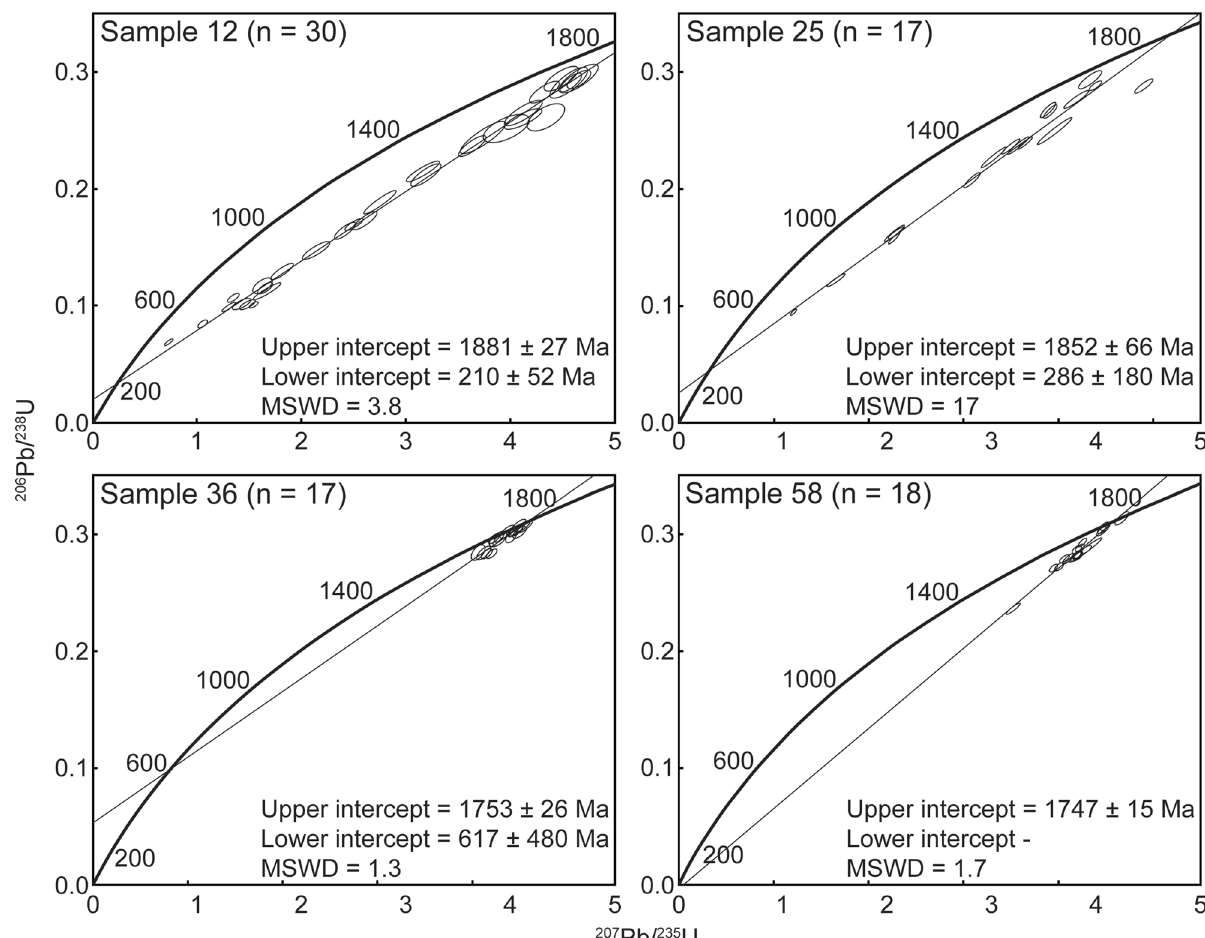
Figure 2. Representative concordia plots for samples outside the central plateau (samples 12 = Järna granite and 25 = Siljan granite) and inside the central plateau (samples 36 = Siljan granite and 58 = Järna granite). (Plots created with with Adobe Illustrator version v. 25.0.1, https:// www. adobe. com/ produ cts/ illus trator. html? promo id= PGRQQ LFS& mv=